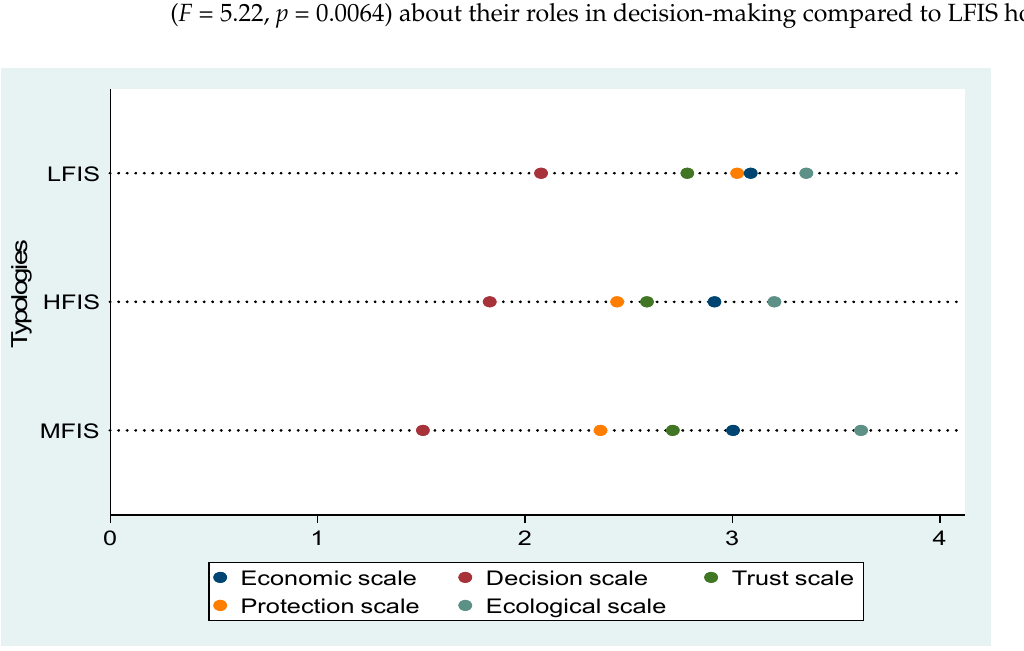
Figure 4. Variation of management and utilization perceptions between the farming typologies. Note: LFIS = Low Forest Income Share, HFIS = High Forest Income Share, and MFIS = Medium Forest Income Share.